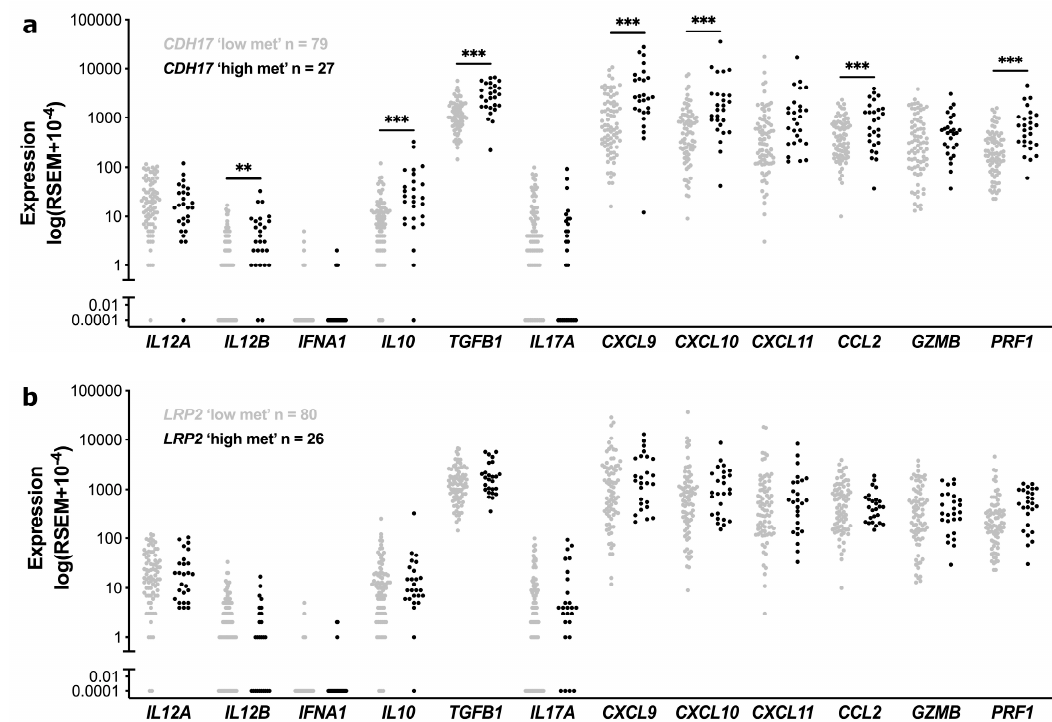
Figure 5. Expression of cytokines related to CD8 T cells (Tc1), NKT, Th17 and MAIT cells, TGFB1 , GZMB, and PRF1 genes according to CDH17 and LRP2 methylation status in stage II CC (TCGA). ( A ) Scatter plot of RNAseq expression levels (log-transformed RSEM raw count) between CDH17 ‘low methylation’ (quartile groups Q1/Q2/Q3, grey dots) versus CDH17 ‘high methylation’ (Q4, black dots) subgroups, as indicated. An unpaired Student’s t -Test was performed; the significance level of p-values between groups are indicated by asterisks (** p -value ≤ 0.01, *** p -value ≤ 0.001). ( B ) Scatter plot of RNAseq expression levels between LRP2 ‘low methylation’ (quartile groups Q1/Q2/Q3, grey dots) versus LRP2 ‘high methylation’ (Q4, black dots) subgroups, as indicated. No significant differences by the Student’s t -Test were observed for the indicated cytokines, TGFB1 , GZMB, or PRF1